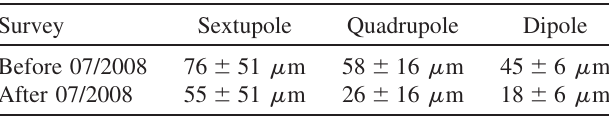
TABLE I. Alignment survey results before and after realign- ment. The numbers show the standard deviation of the vertical position of all the magnets with respect to a common plane. The error on these numbers indicates the fiducial and assembly errors, which cannot be corrected and thus represent the lowest achievable alignment